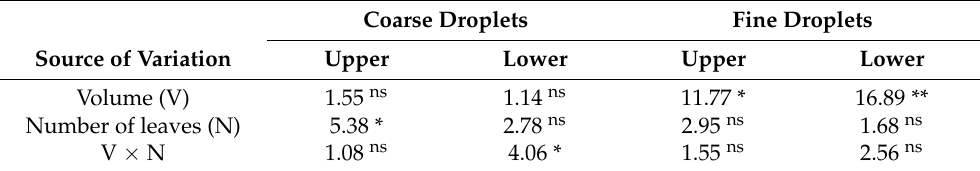
Table 1. A summary of the analysis of variance (F test) for the amount of tracer extracted from coffee leaves as a function of the volume of the extraction solution (fixed or variable) and the number of leaves per sample.